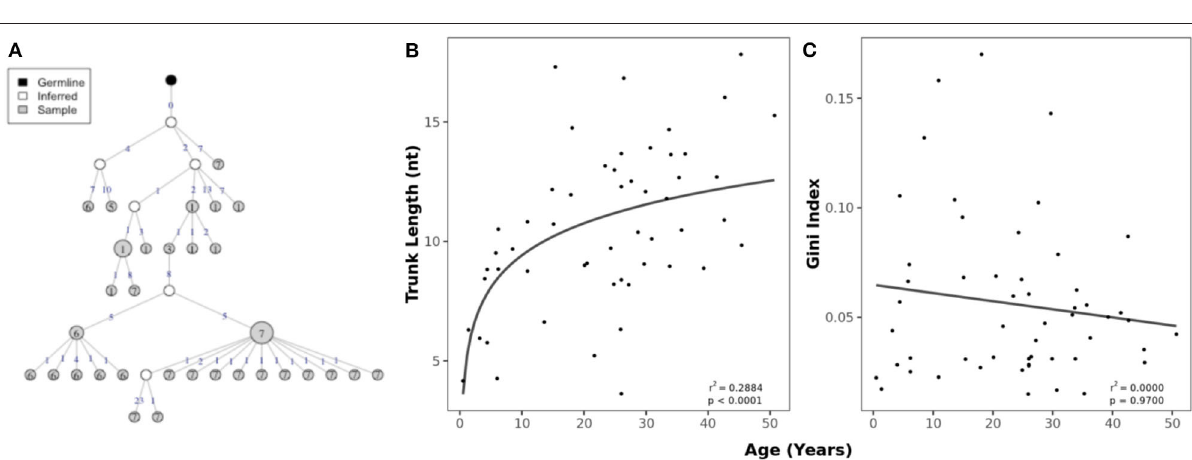
FIGURE 4 | Age-related changes in clonal expansions. (A) Example lineage tree with each node representing a sequence and the size of the node indicating the number of identical sequences. The number of mutations between the sequences (nodes) is shown on top of the connecting lines. (B) Correlation between age and mean trunk length with a fitted logarithmic curve. (C) Correlation between mean Gini index and age with a fitted linear